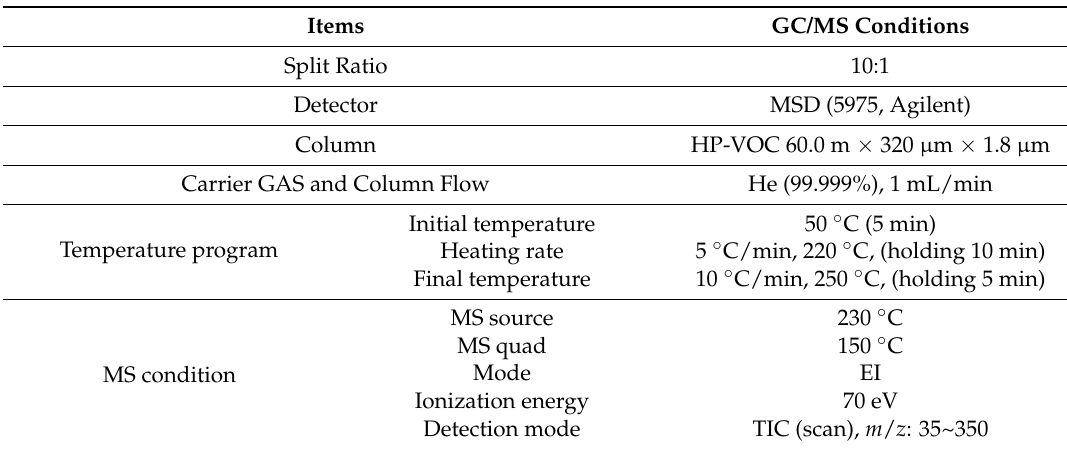
Table 2. Conditions for VOC analysis using GC/MS.